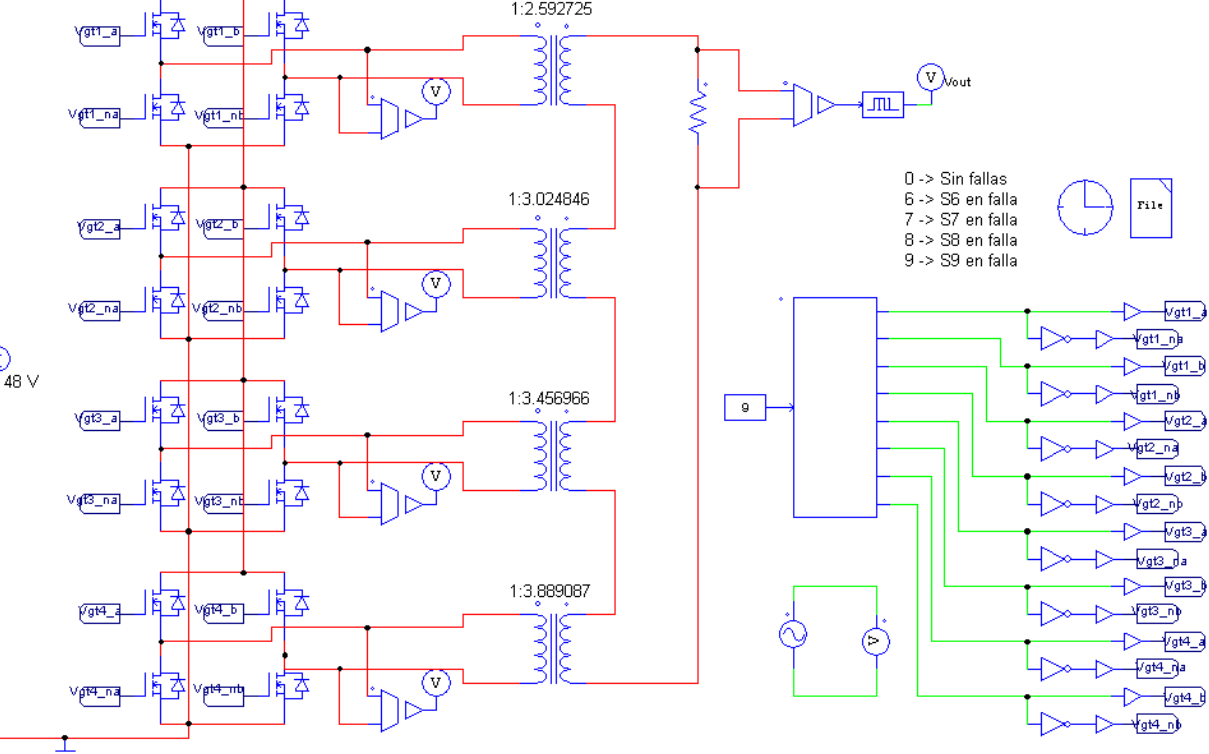
Figure 14. PSIM simulation used to obtain validation